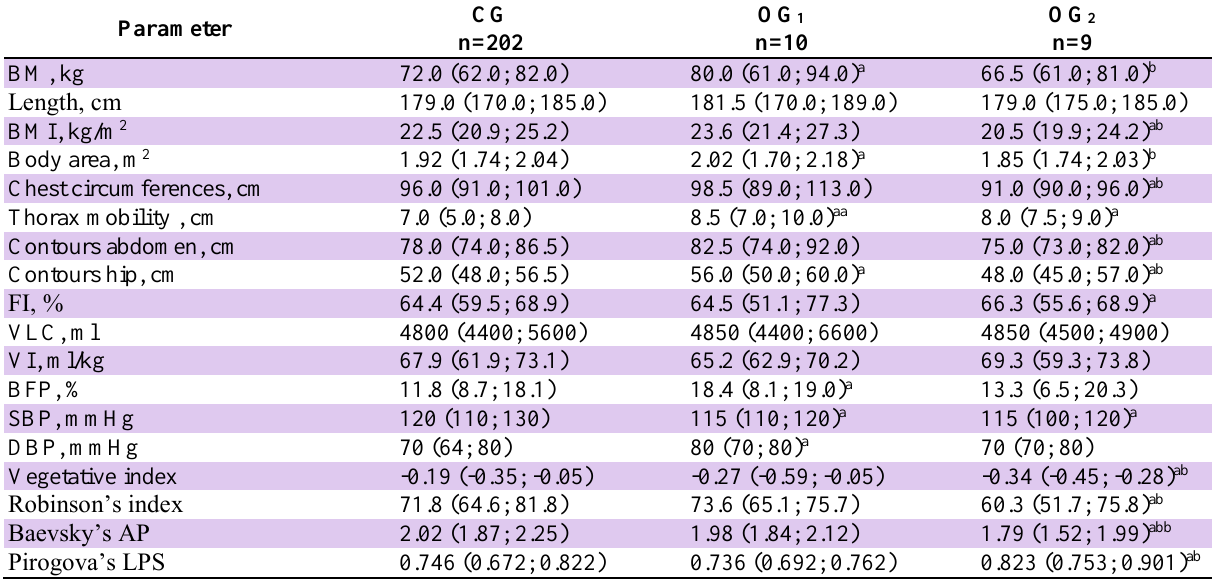
Table 1. Morphofunctional differences athletes at baseline at overstrain by sympathetic (OG 1 ) and parasympathetic (OG 2 ) in comparison with comparison group